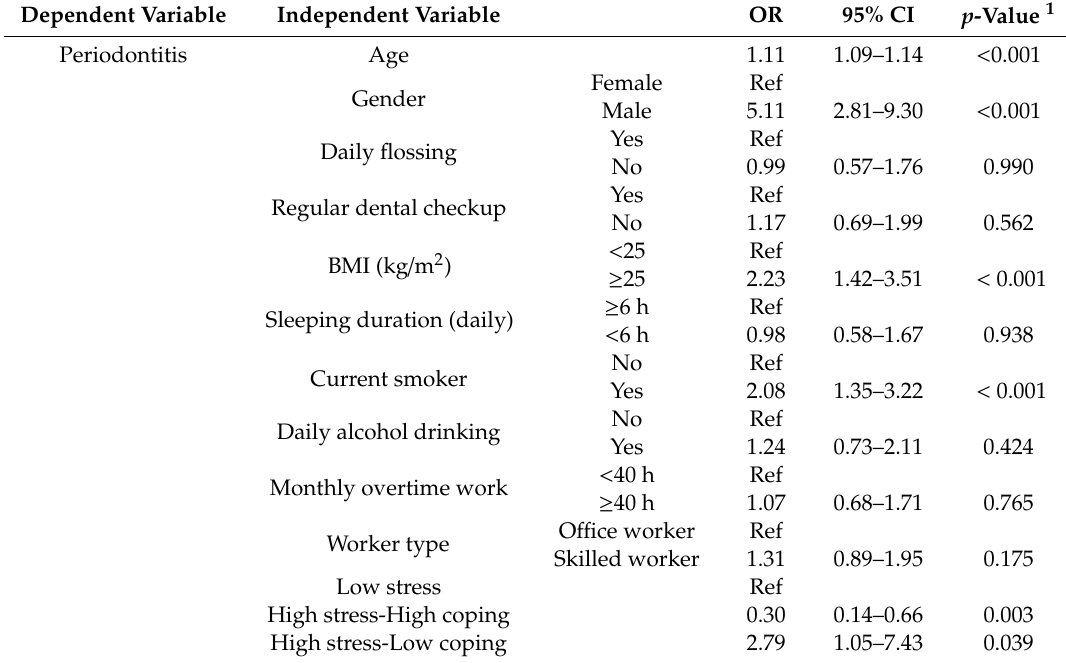
Table 3. Adjusted odds ratios (OR) and 95% confidence intervals (95% CI) for